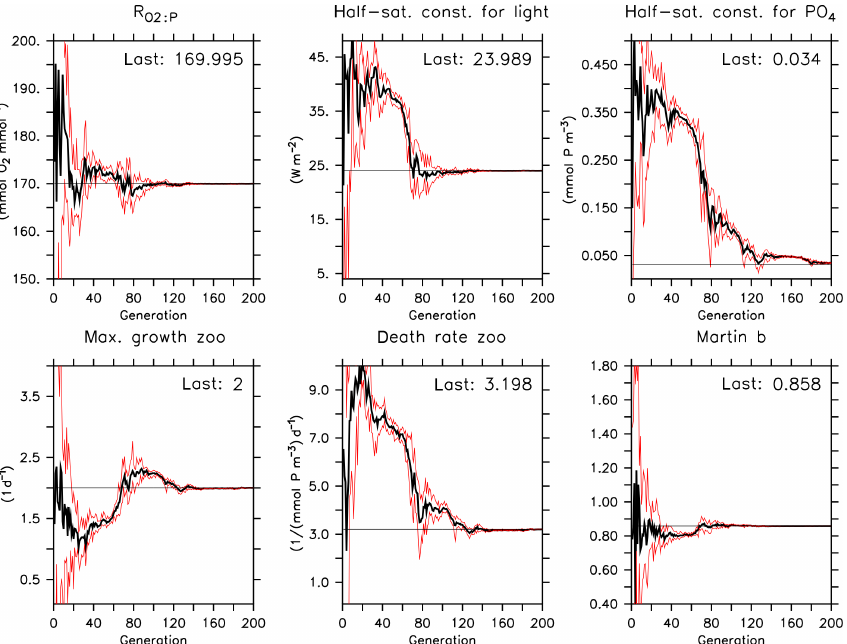
Figure 3. Optimization trajectory for six parameters of the twin experiment. The thick black line shows the average parameter of all 10 individuals of a generation. Red lines indicate their maximum and minimum parameter values. Horizontal black lines indicate the target parameter. Note that we restrict the y -axis to the maximum and minimum